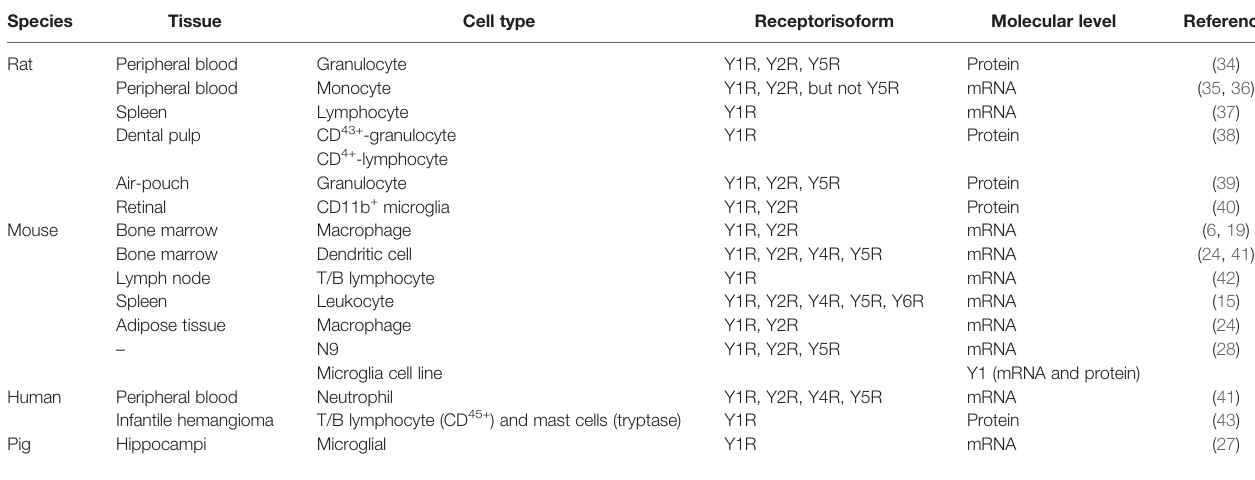
TABLE 2 | Neuropeptide Y receptors in immune cells.